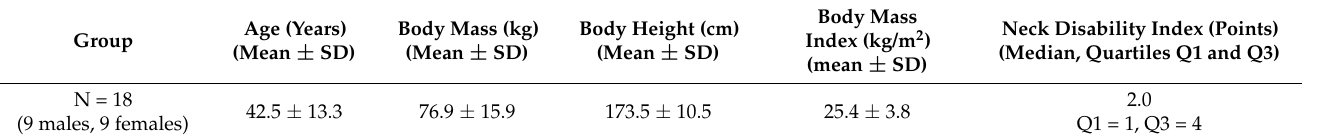
Table 1. Characteristics of the